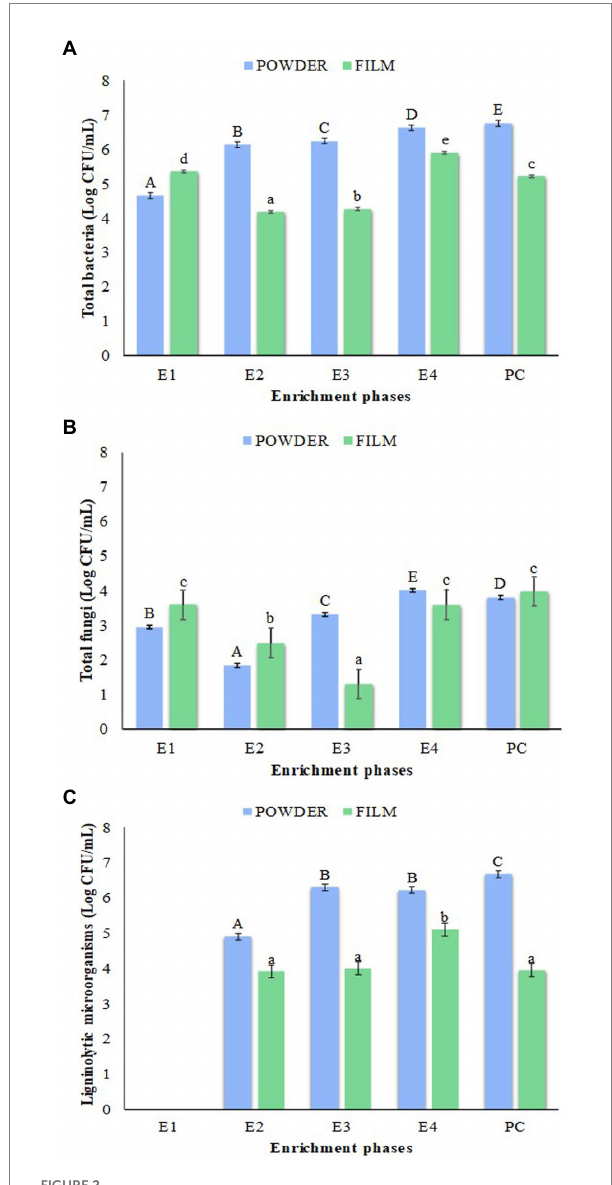
FIGURE 2 Counts of total bacteria (A) , total fungi (B) , and ligninolytic microorganisms (C) on the enrichment process with LLDPE powder (blue bars) and film (green bars), in addition to PC. E1, E2, E3 and E4: Enrichments 1, 2, 3 and 4; PC: Prolonged culture. The values are the average of three replicates. Error bars represent LSD interval, the bars bearing different letters were significantly different according to Fisher’s LSD test ( p < 0.05) (uppercase letters for film format of LLDPE and lowercase letters for film